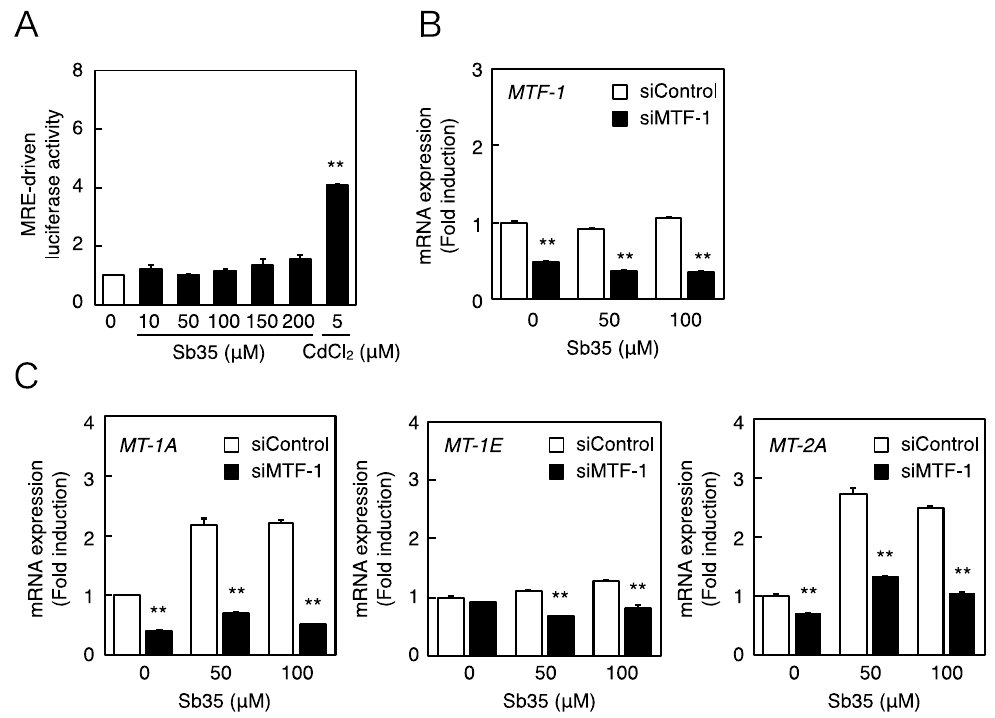
Figure 3. The MTF-1–MRE pathway mediates Sb35-induced transcription of endothelial MT-1A , MT-1E , and MT-2A . ( A ) MRE-driven transcriptional activity. Vascular endothelial cells transfected with an MRE reporter vector were treated with or without 10, 50, 100, 150, or 200 µM Sb35 or 5 µM cadmium for 12 h, and MRE-driven transcriptional activity was determined by performing the MRE-directed reporter assay; ( B ) siRNA-mediated MTF-1 knockdown. Vascular endothelial cells transfected with control or MTF-1 siRNA were treated with or without 50 or 100 µM Sb35 for 12 h, and expression of MTF-1 mRNA was determined by performing real-time RT-PCR. Data are expressed as the mean ± SE of three samples. ** p < 0.01 indicates significantly different from the corresponding siControl; ( C ) Sb35-induced transcription of endothelial MT-1A , MT-1E , and MT-2A after MTF-1 knockdown. Vascular endothelial cells transfected with control or MTF-1 siRNA were treated with or without 50 or 100 µM Sb35 for 12 h. Data are expressed as the mean ± SE of three representative samples, with each sample obtained from three independent experiments. ** p < 0.01 indicates significantly different from the corresponding siControl.